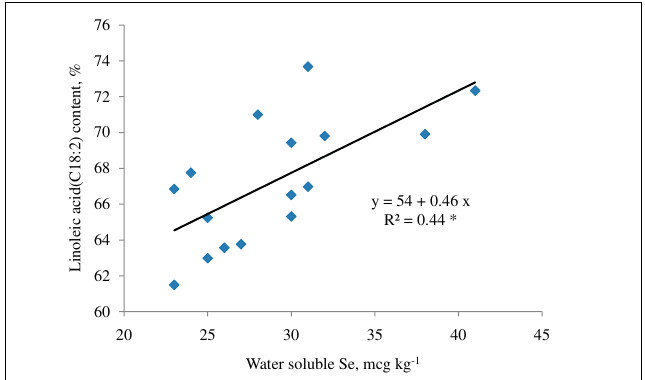
Fig.3 Fig. 3 - Correlation between selenium water soluble forms and linoleic content in Allium seeds (r = 0.66, P<0.05).